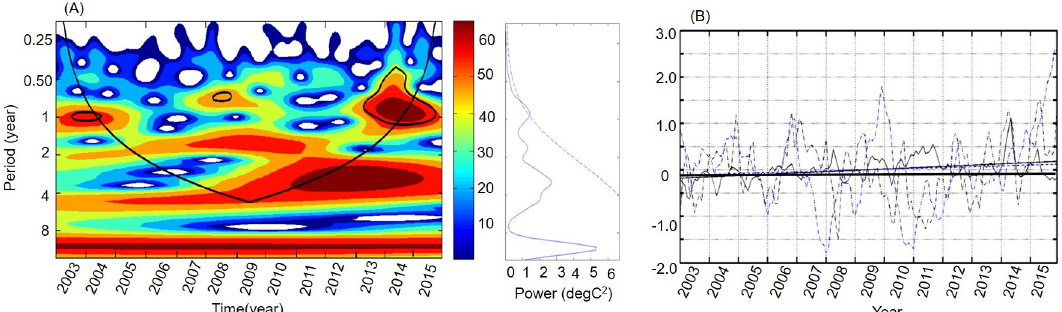
Fig 6. Variation in Chl- a , SST, and Ni ñ o 3.4 in the Yellow Sea, China. (A) Wavelets of the amplitudes for Chl- a after seasonal variation had been removed (the blue dotted line shows the 95% confidence level, and the solid blue line is the global power spectrum in the right panel, respectively). The warm color indicates high power in an arbitrary unit. (B) Time series of mean anomalies for Chl- a , SST, and Ni ñ o 3.4 (the black lines are Chl- a anomalies and least-square linear fits; the black dotted lines are SST anomalies and least-square linear fits; the blue lines are Ni ñ o 3.4 and least-square linear